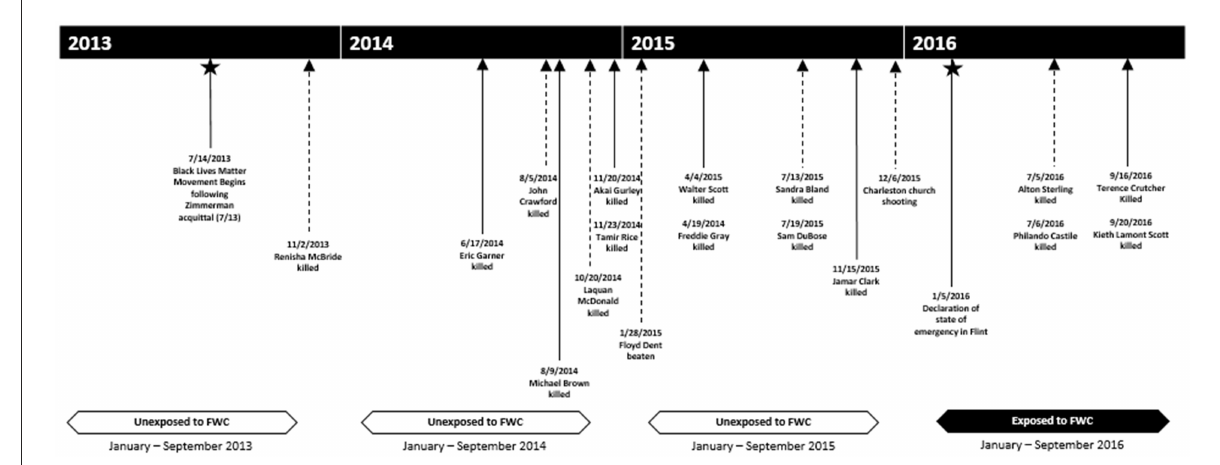
FIGURE2 Timeline of highly publicized instances of racialized violence relative to exposure period, 2013–2016.